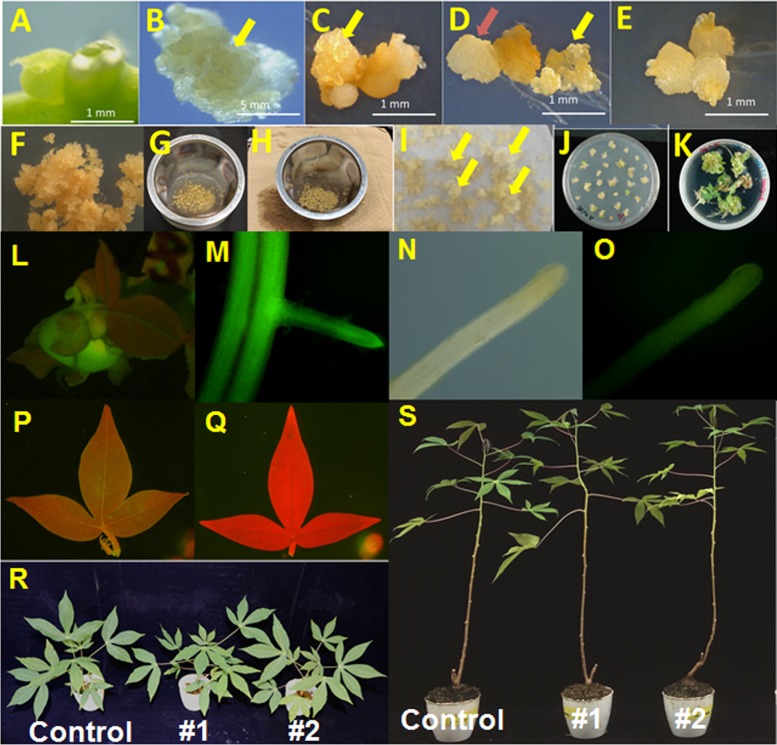
FEC induction and genetic transformation of the cassava cultivar ‘60444’.(A) AB formed in stem cuttings cultured on CAM, (B) SE produced on CIM, (C) SE produced on DKW, (D) non-FEC (red arrow) and FEC (yellow arrow) produced on CIM-Ρ NPK, (E) non-FEC cultured on FIM for an additional two weeks after transferring non-FEC in Fig 1D to fresh FIM, (F) FEC cultured on FIM for additional 4 weeks after transferring FEC in Fig 1D to fresh FIM, (G) Collection of FEC in a tea filter (30 mesh) and soaking the collected FEC in an Agrobacterium (EHA105) suspension for 2 min, (H) removal of excess Agrobacterium (EHA105) suspension by blotting on distilled Kimtowel, (I) multiplying FEC (shown in yellow arrows) on FIM amended with 20 mg/L of hygromycin, (J) induction of cotyledons from FEC on MSN amended with hygromycin, (K) induction of shoots on CEM from transferred cotyledons, (L) GFP fluorescence in transgenic in vitro plantlet of cassava, (M) GFP fluorescence in root tissue of a transgenic plantlet of cassava, (N) observation of root from non-transgenic in vitro plant using light microscope, (O) observation of root from non-transgenic in vitro plant using fluorescence microscope, (P) GFP fluorescence in leaves of transgenic plant, (Q) absence of GFP fluorescence in a non-transgenic cassava plant, and phenotype of transgenic (#1 and #2) and non-transgenic (control) cassava plants cultured for 2 (R) and 4 (S) months at 28°C in greenhouse after cutting.